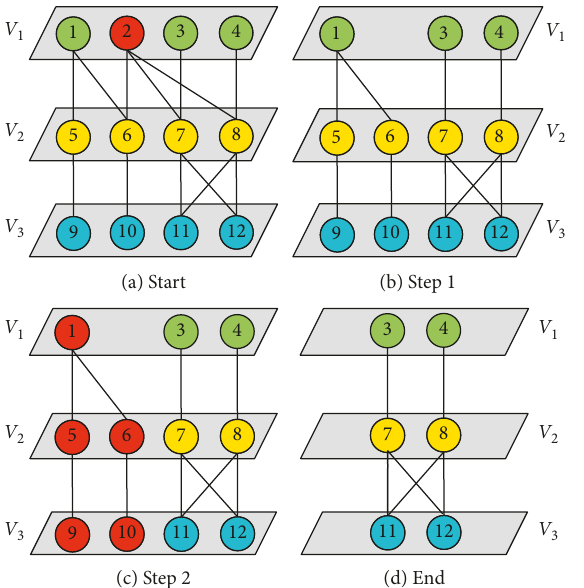
Figure 5: Proposed model M1 for depicting the cascading failures of a multipartite network subject to node attacks. (a) Initially, node 2 of partite set V is attacked. (b) The removal of node 2 breaks the 1 focal multipartite network into two parts. (c) The model M1 as- sumes that only nodes in the LCC survive the attack, and therefore, the nodes marked in red will be removed. (d) Eventually, nodes 3, 4, 7, 8, 11, and 12 are remained.